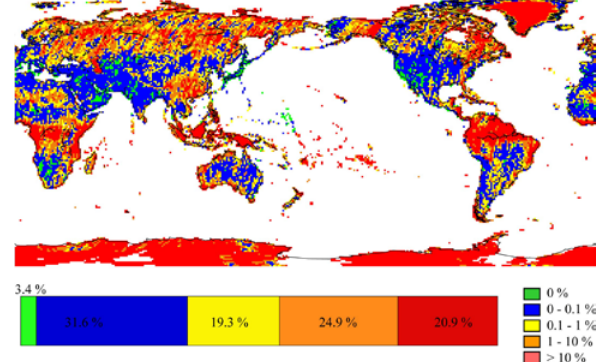
Figure 3. Tile based bad pixel rate distribution and statistics of ASTER GDEM version 2 except for Antarctica